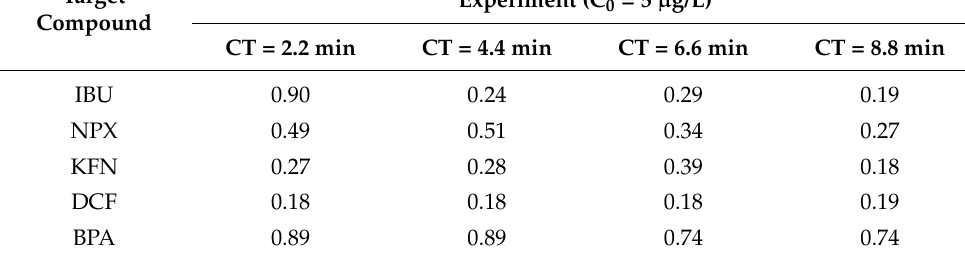
Table 5. The ratio of mass of pollutant removed per mass of the nanocomposite material (R-nFe) at the end of each experiment, conducted at four different contact times (initial concentration of each pollutant 5 µ g/L, without pH